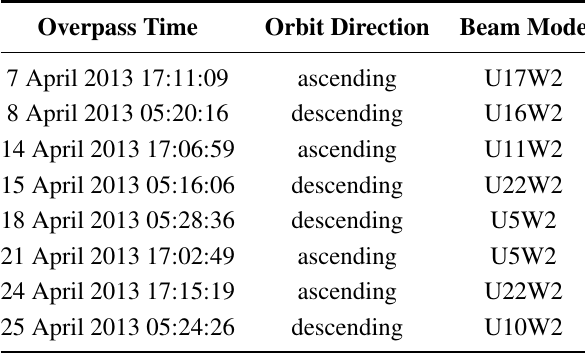
Table 1. Overview of approximate acquisition times (in UTC). Overpass Time Orbit Direction Beam Mode